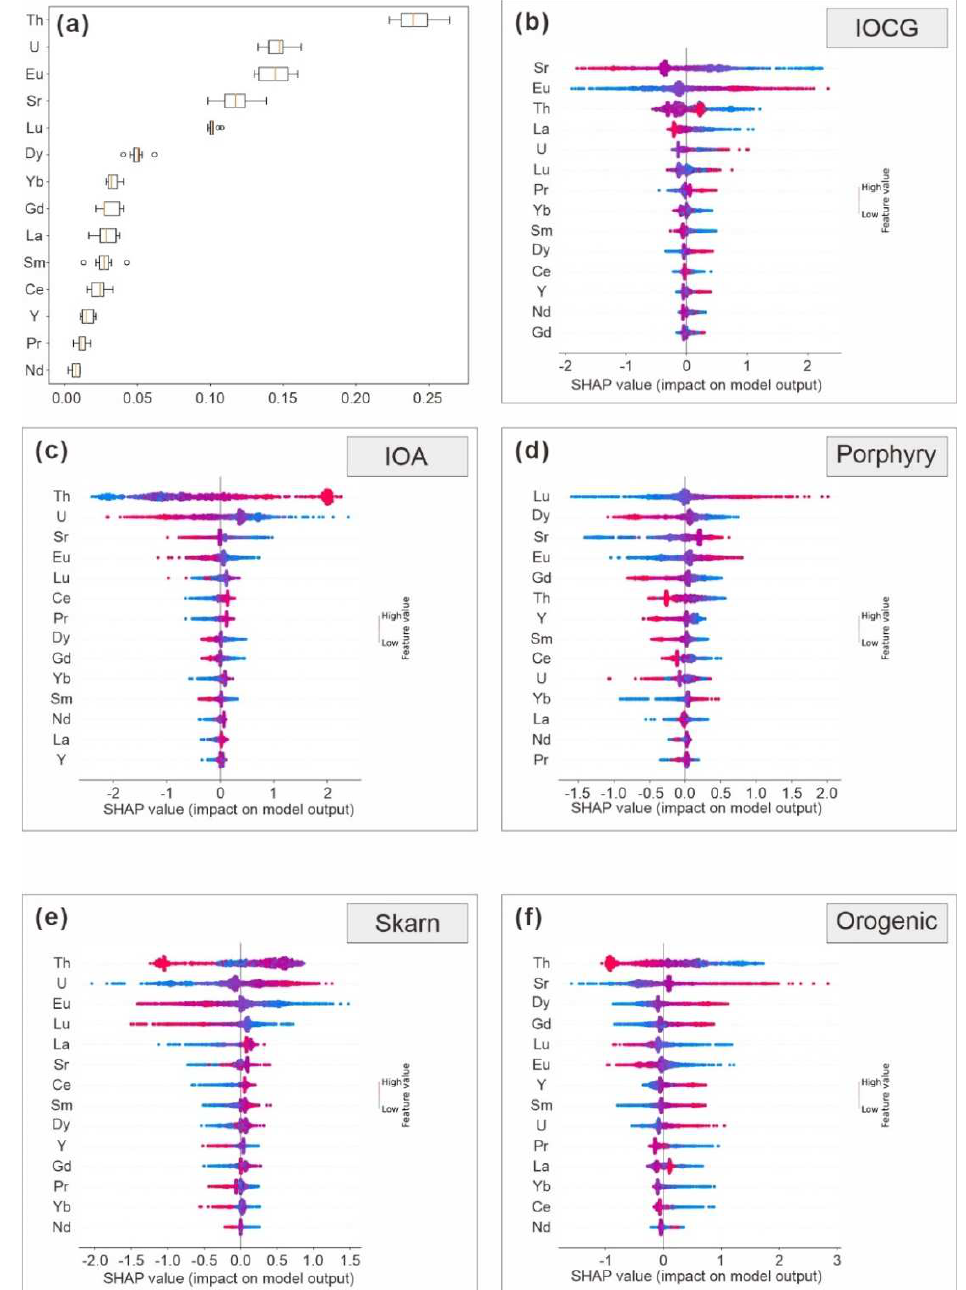
Figure 5. Feature importance scores and SHAP values generated by SVM. ( a ) Feature importance scores. ( b – f ) SHAP summary plots of apatite from various ore sources. A small circle (dot) represents an individual analysis and the color represents the concentration of the respective element (red = high, blue =